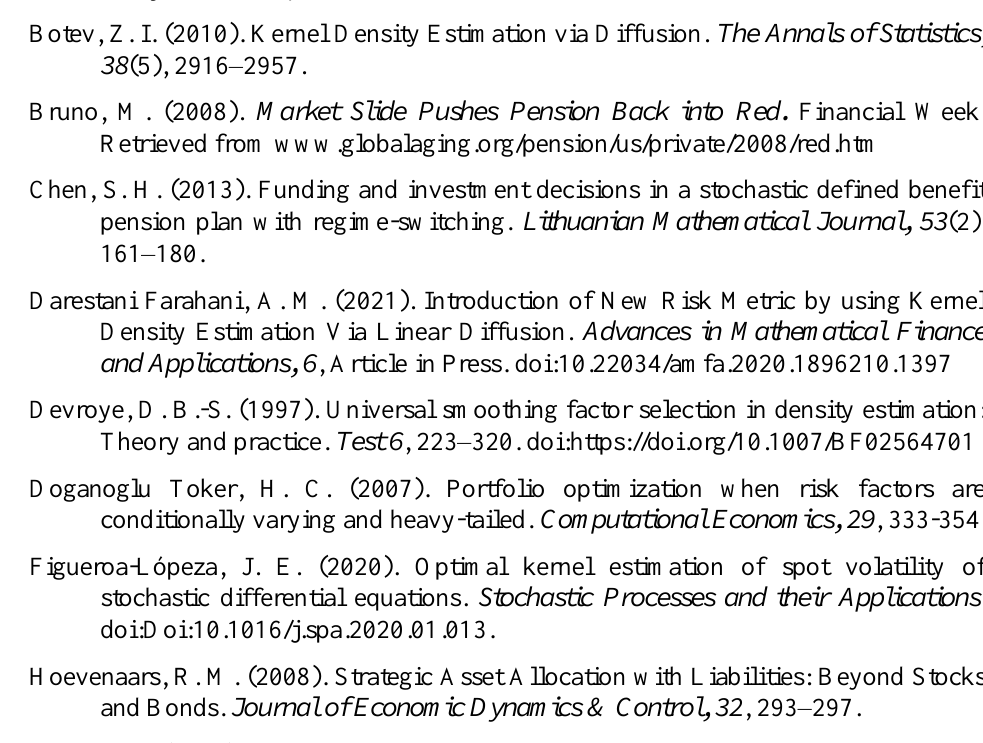
Figueroa-Lópeza, J. E. (2020). Optimal kernel estimation of spot volatility of stochastic differential equations. Stochastic Processes and their Applications